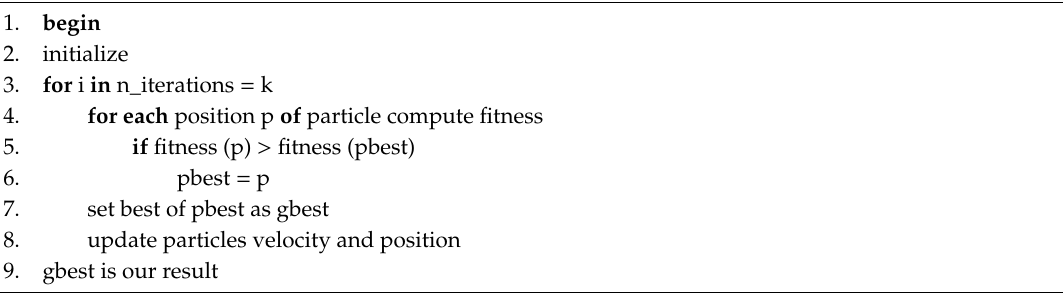
Algorithm 1. Simple particle swarm optimization (PSO)